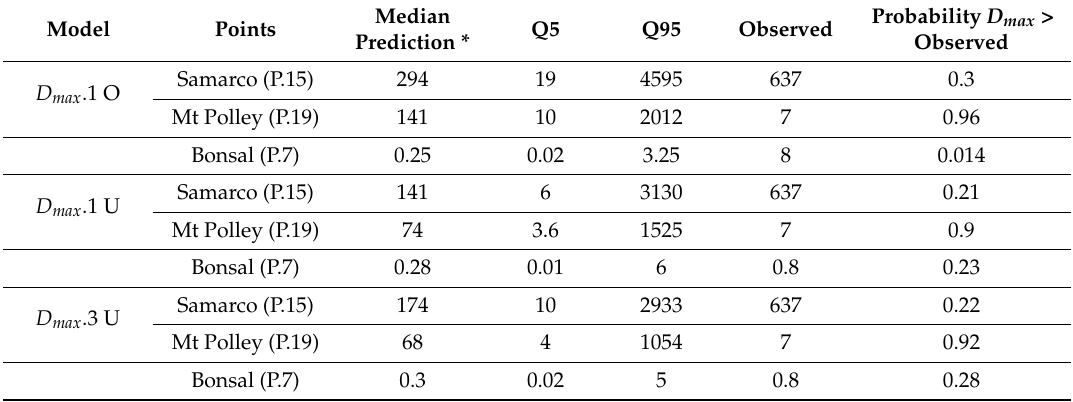
Table 6. Predicted values (in km) using all the data points for training the models (using the observed V F ).